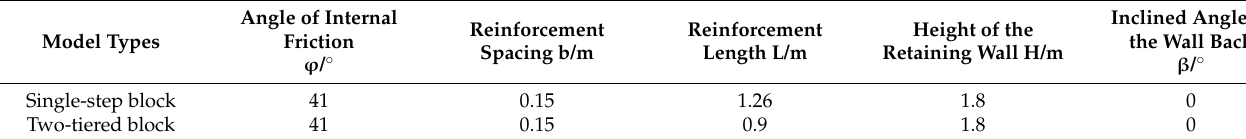
Table 3. Calculation and test parameters.